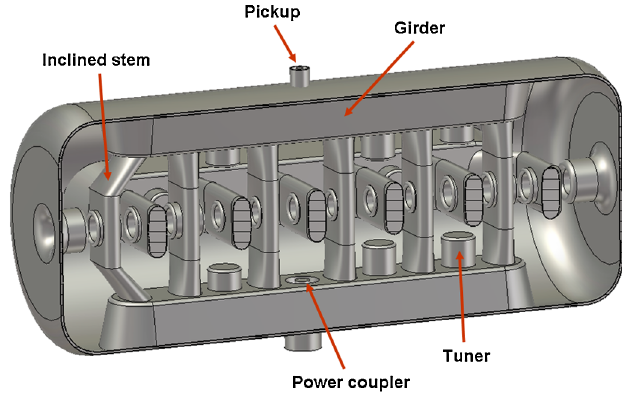
FIG. 12. (Color) Layout of the first superconducting EUROTRANS CH cavity (simulation with MICROWAVE STUDIO